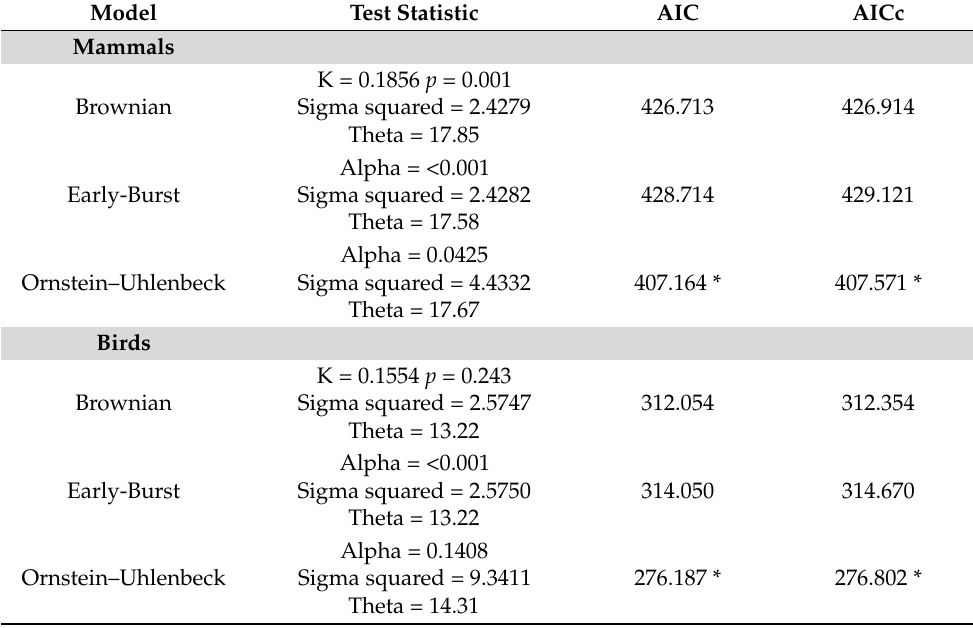
Table 1. Comparison of phylogenetically signals of intraocular pressure (IOP) in mammals and birds using three modes of evolution (Brownian, Pagel’s lambda, Early-burst, and Ornstein-Uhlenbeck). Asterisks are the model with the lowest AIC value. Test